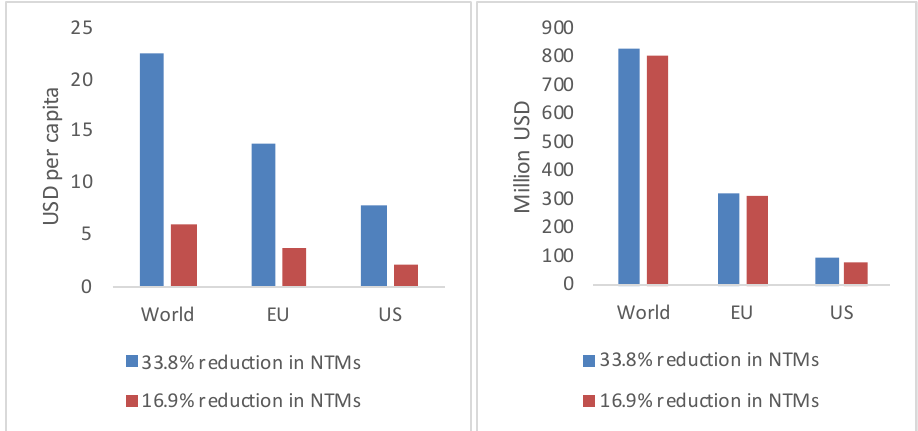
Figure 3. Change in welfare [Equivalent variant per capita in constant USD] and export volumes [Mil- lion constant USD] under lower reduction of NTMs.